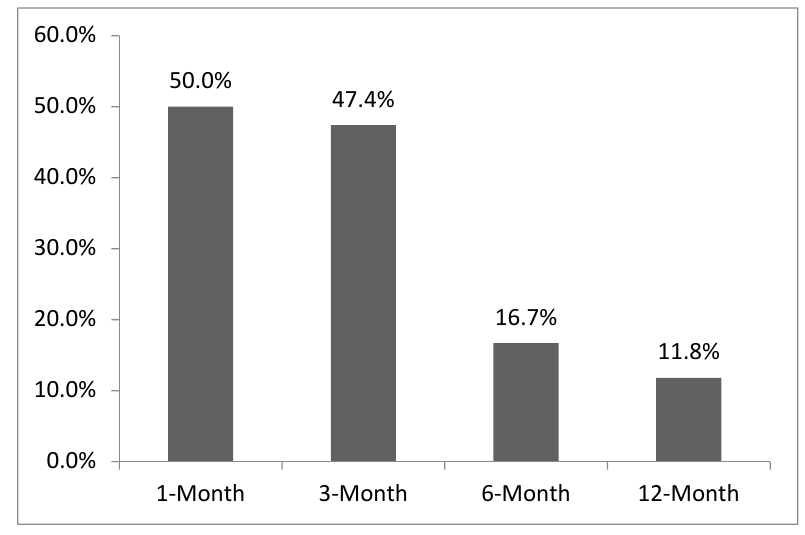
Figure 2. rPSMF adherence rate over 12 months.